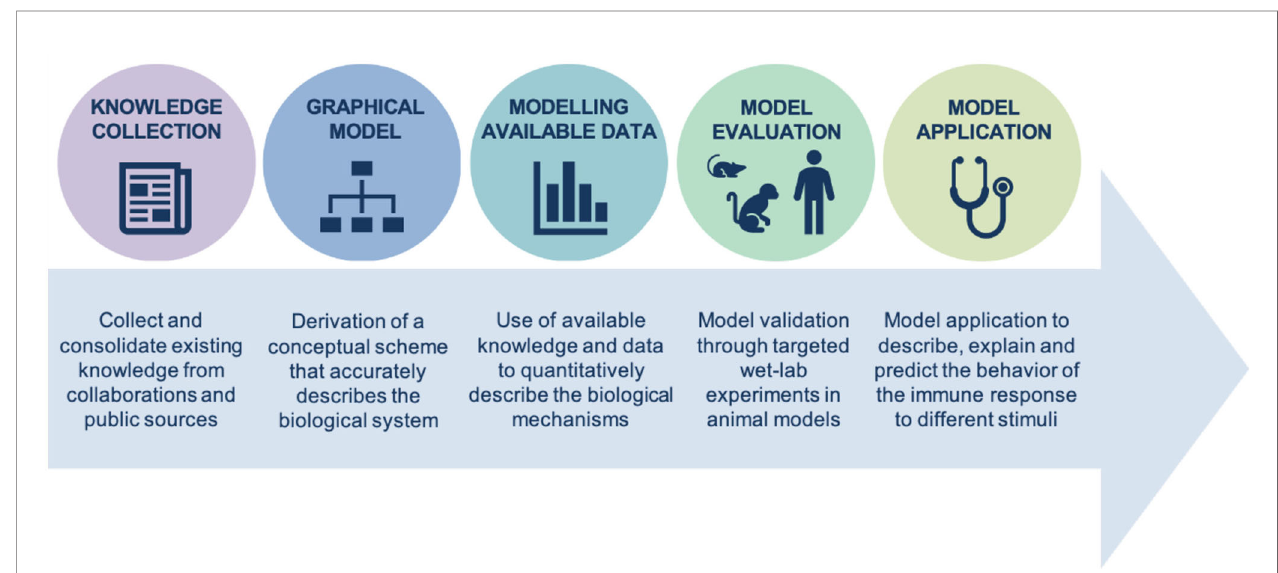
FIGURE 1 | In silico modeling of the immune system. Integrative systems biology approach to properly describe, explain, and predict the behavior of any biological mechanism, which in our speci fi c case study is the immune response to mRNA-based